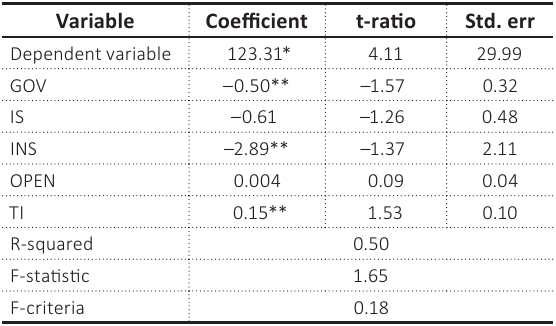
Table 6. Cross-sectional data analysis, 2020